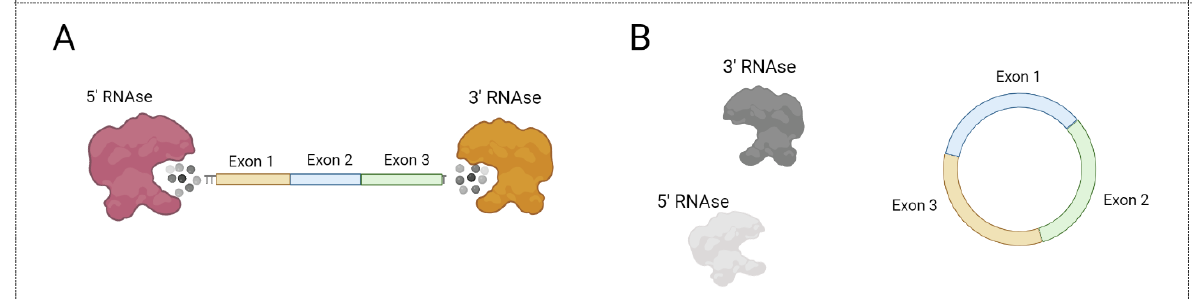
Figure 6. CircRNA protection from exonuclease action. ( A ) Linear mRNA can be degraded by 5’ RNAse and 3’ RNAse. ( B ) Circular mRNA cannot be degraded by 5’ RNAse and 3’ RNAse. Figure was created using BioRender tool.